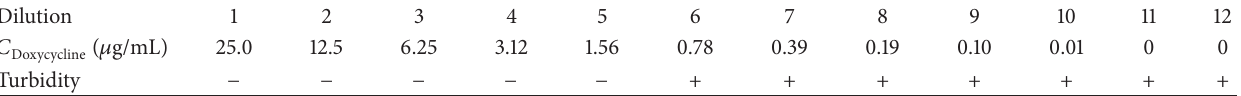
Table 1: Scheme of doxyxycline microdilutions in 96-well microplate for MIC determination using E. coli as a target microorganism. Dilution 𝐶 ( 𝜇 g/mL) Doxycycline